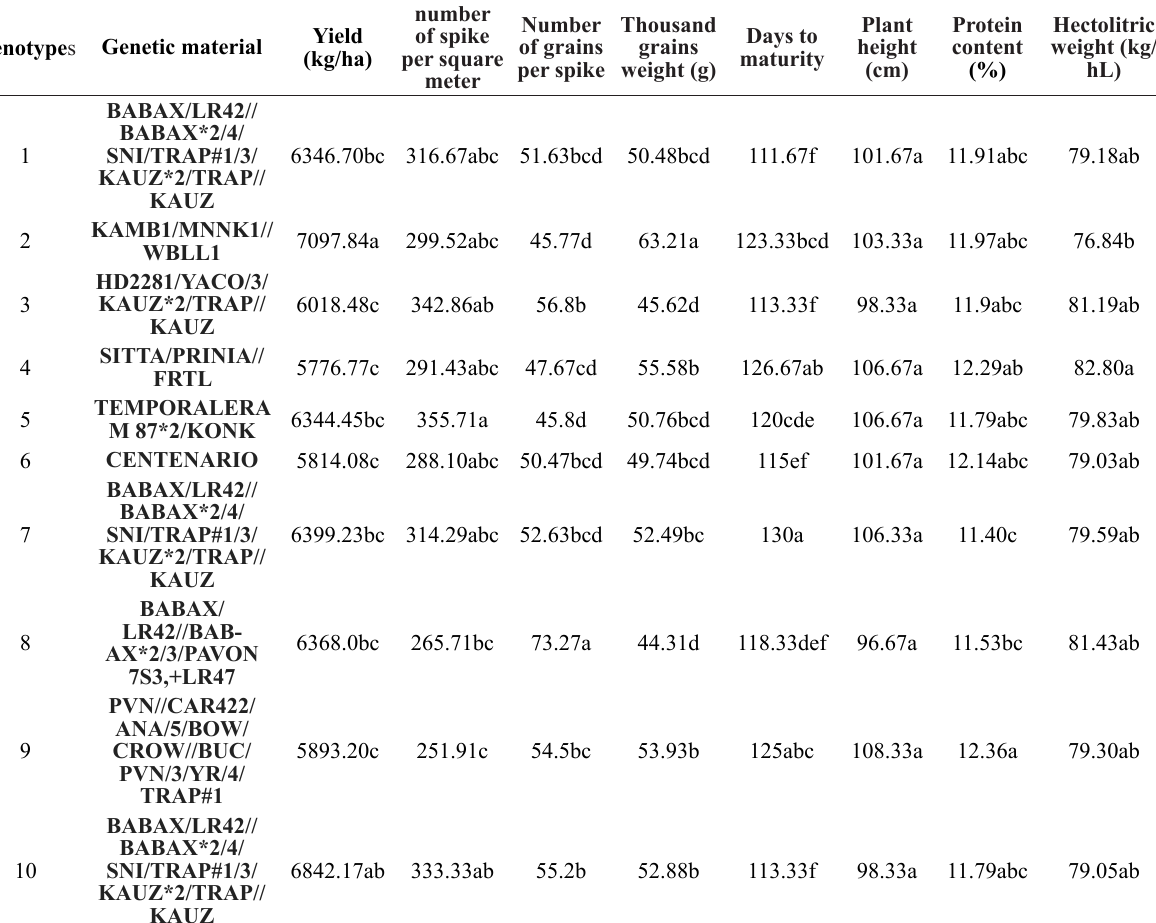
Table 6 . Mean values of grain yield, number of spikes per square meter, number of grains per spike, thousand grains weight (g), days to maturity, plant height (cm), grain protein (%) and hectolitric weight of the drought experiments of the assessment of tolerant wheat genotypes ( Triticum aestivum L) to drought under conditions of La Molina LM